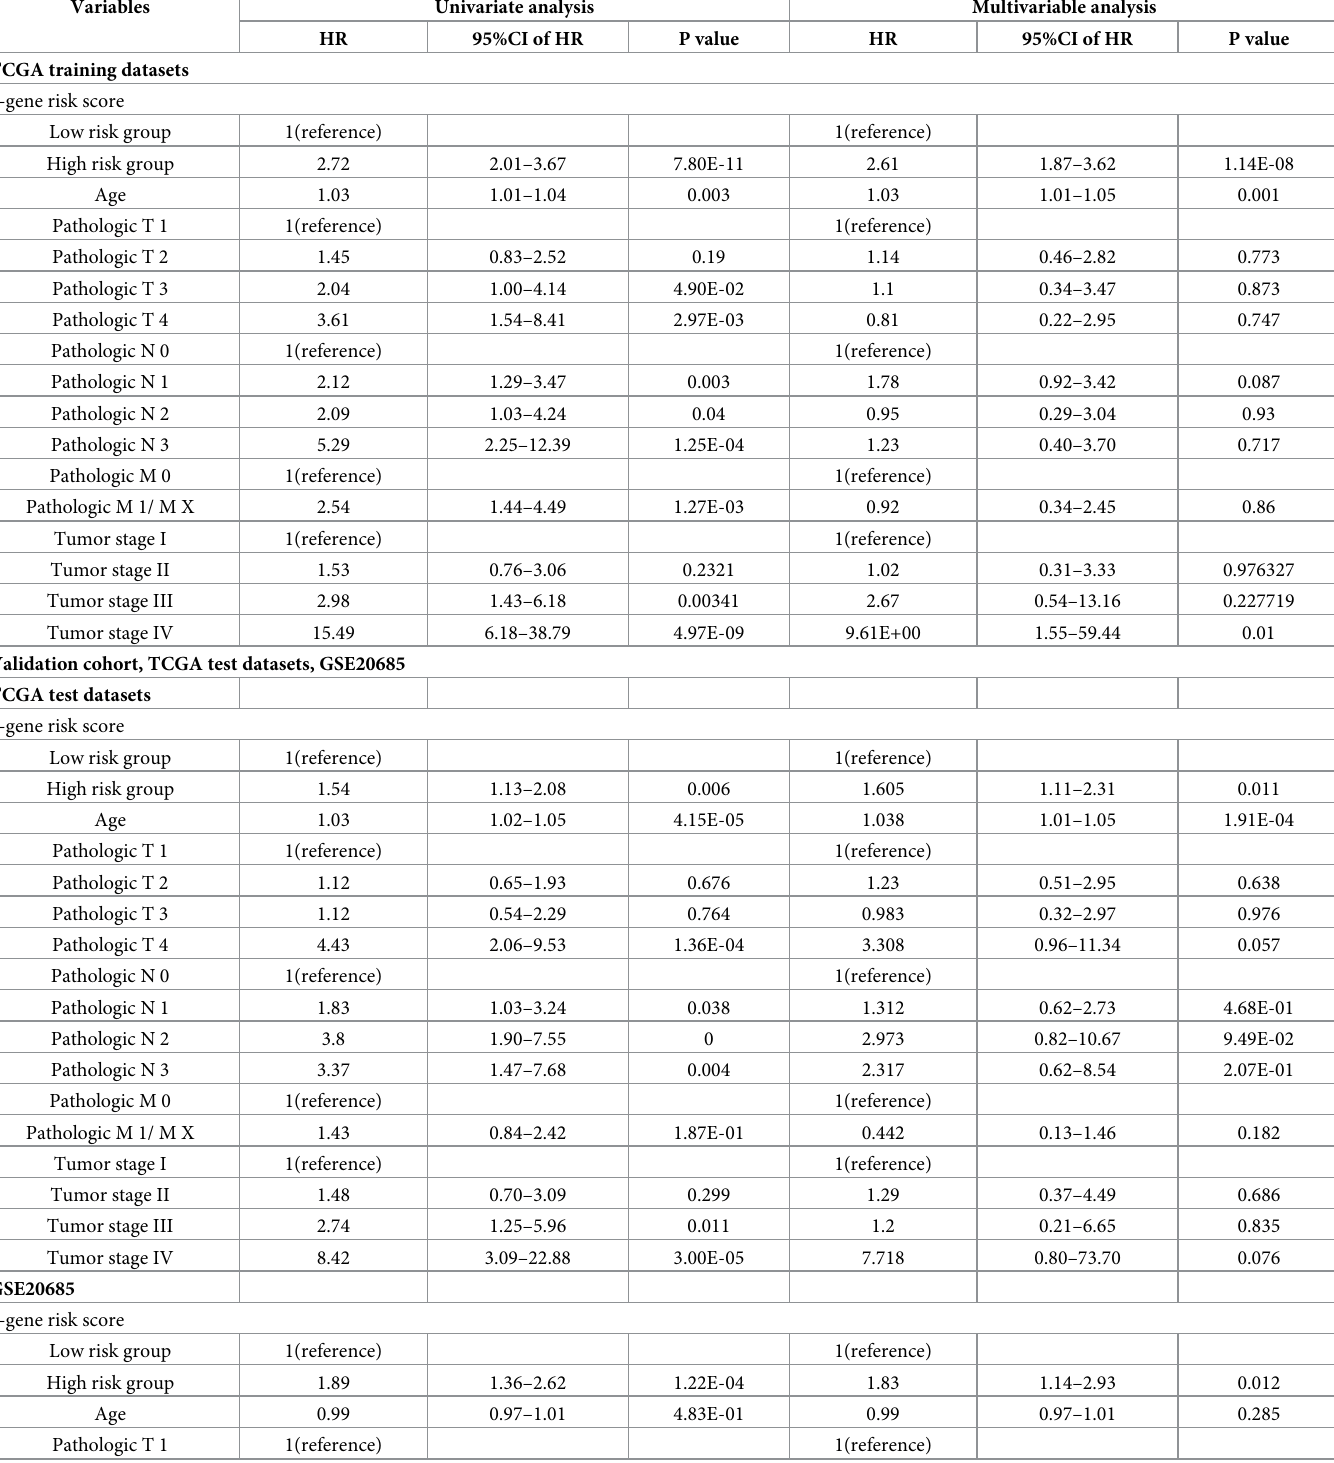
Table 3. Univariate and multivariate COX regression analysis was used to identify prognostic clinical factors and clinical independence in the TCGA training set, TCGA test set and